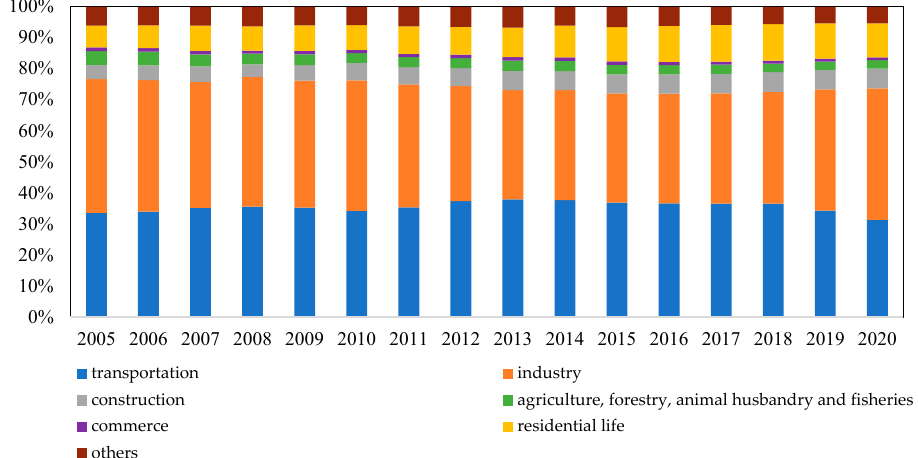
Figure 2. End consumption shares of different sectors.